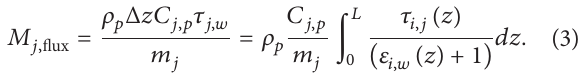
PCA results show that pH value and alkali and alkaline earth elements significantly influence chemical weathering and that Mg, Ca, Na, and K are almost depleted or depleted-added in the weathering